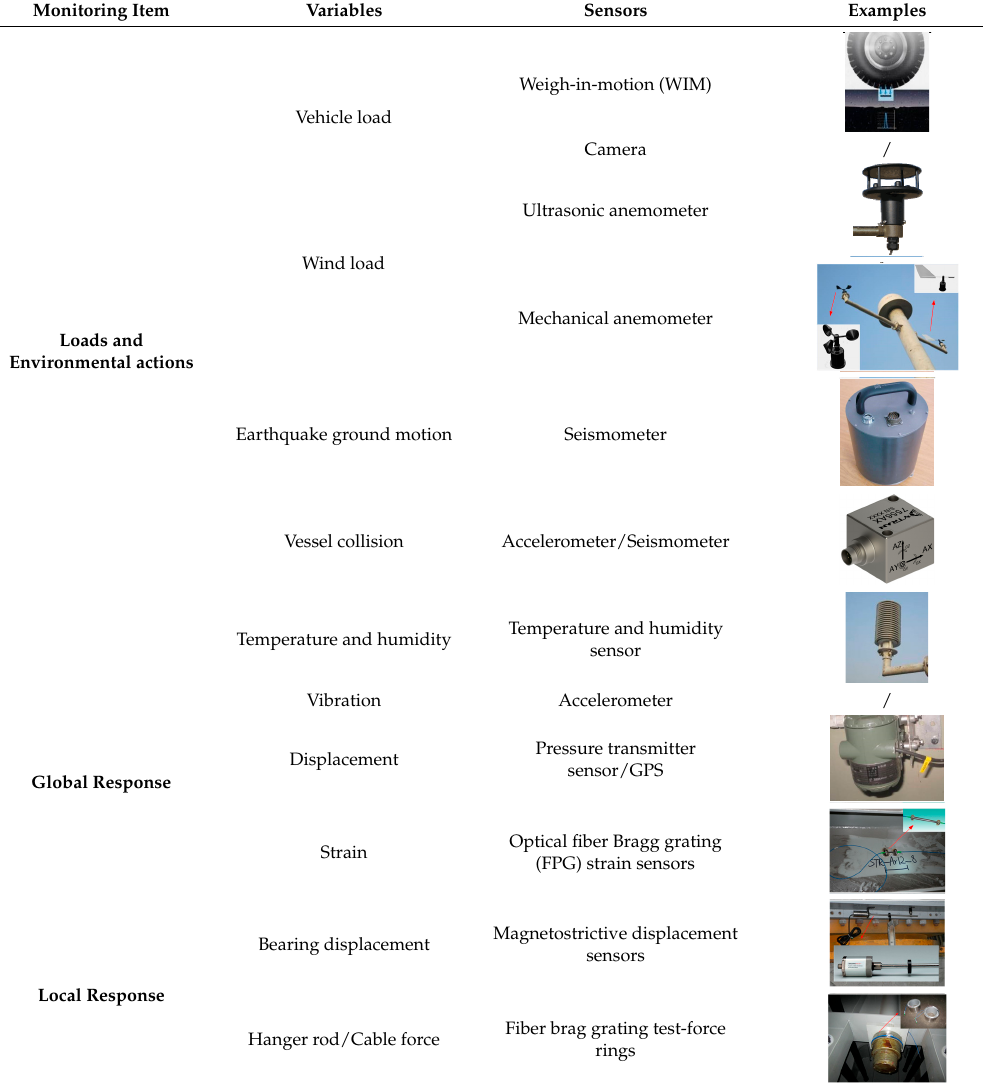
Table 1. Sensors often utilized in a sensory sub-system.